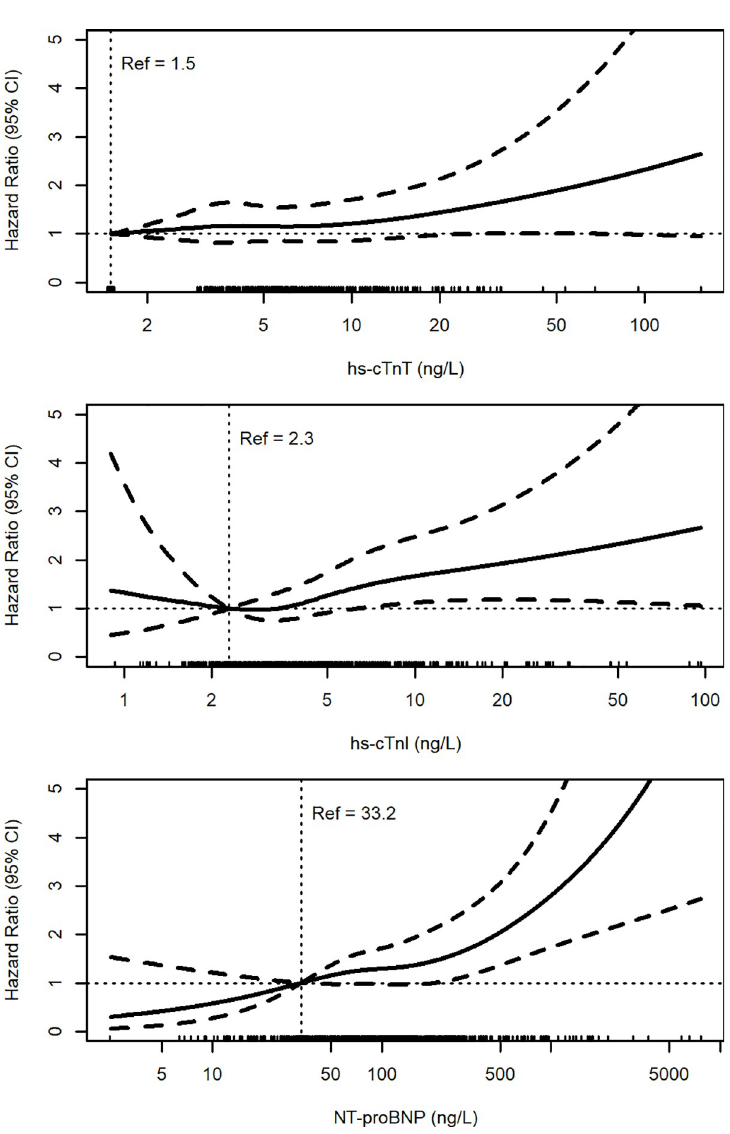
Fig 1. Relationship between cardiac biomarker levels and mortality. Adjusted for age, sex, BMI, smoking status, localization of OA, diabetes, cholesterol, and log-transformed concentrations of cystatin C, hs-cTnT, hs-cTnI, and NT-